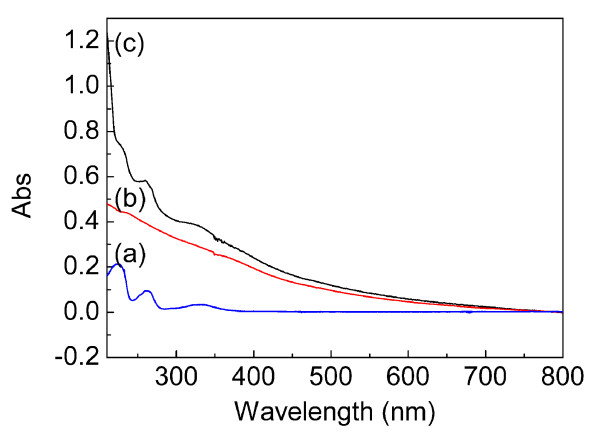
UV-Vis spectra of DTH-APTES (a), Fe3O4@SiO2 (b), and DTH-Fe3O4@SiO2 (c).